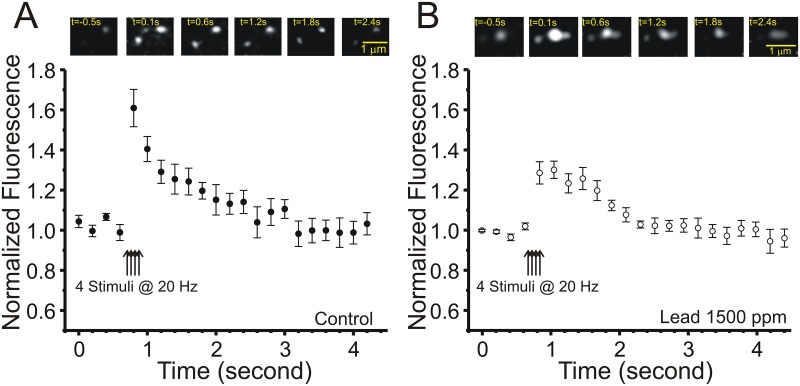
Chronic Pb2+ treatment does not produce marked changes in presynaptic Ca2+ influx into Schaffer collateral terminals.Mean ± SEM presynaptic stimulus-evoked Mg2+-Green fluorescence increases in presynaptic terminals in response to a burst of Schaffer collateral stimuli (4x20Hz) in slices from control (A, filled circles, N = 10 control slices, 25 terminals) versus Pb2+-exposed (B, open circles, N = 13 slices, 32 terminals) rats (insets above are single fluorescent spines from a control and Pb2+-exposed slice at the indicated time points post-stimulation).